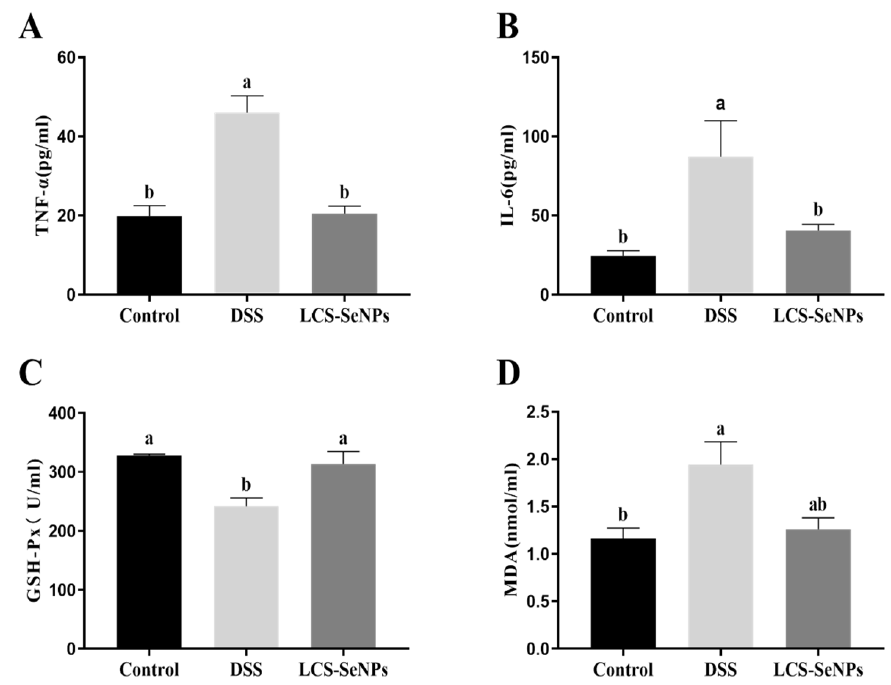
Figure 6. Effects of LCS-SeNPs supplementation on colon tissue inflammation cytokine and antioxidant parameters in DSS-induced colitis mice. The inflammation cytokine levels of TNF- α ( A ) and IL-6 ( B ) in colon tissue; the levels of GSH-Px ( C ) and MAD ( D ) in colon tissue. Data are presented as mean ± SEM. In the same column values with different letters superscripts differ significantly ( p < 0.05).